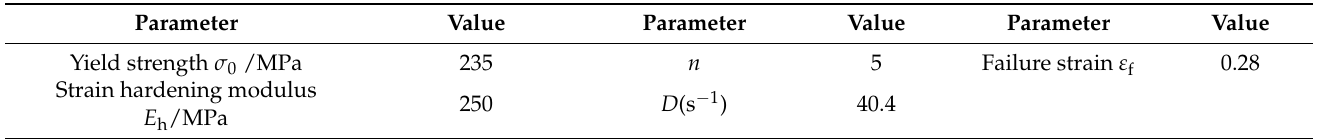
Table 2. Material parameters of Q235 steel.